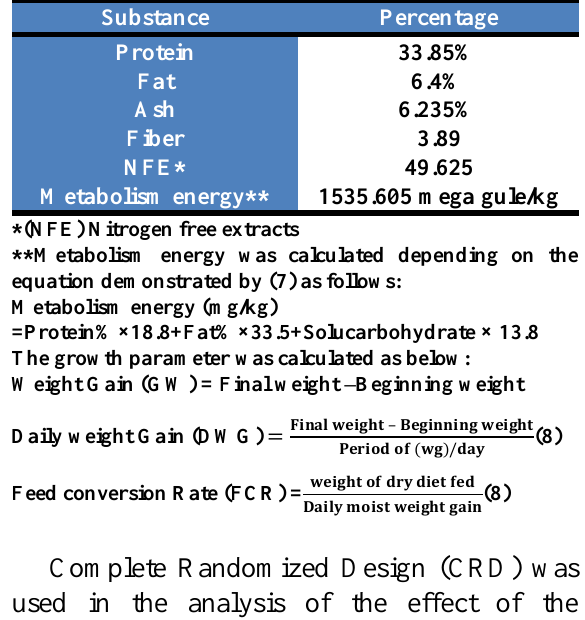
Table, 2: Chemical analysis % calculated on basis of dry matter by using to replicates for each